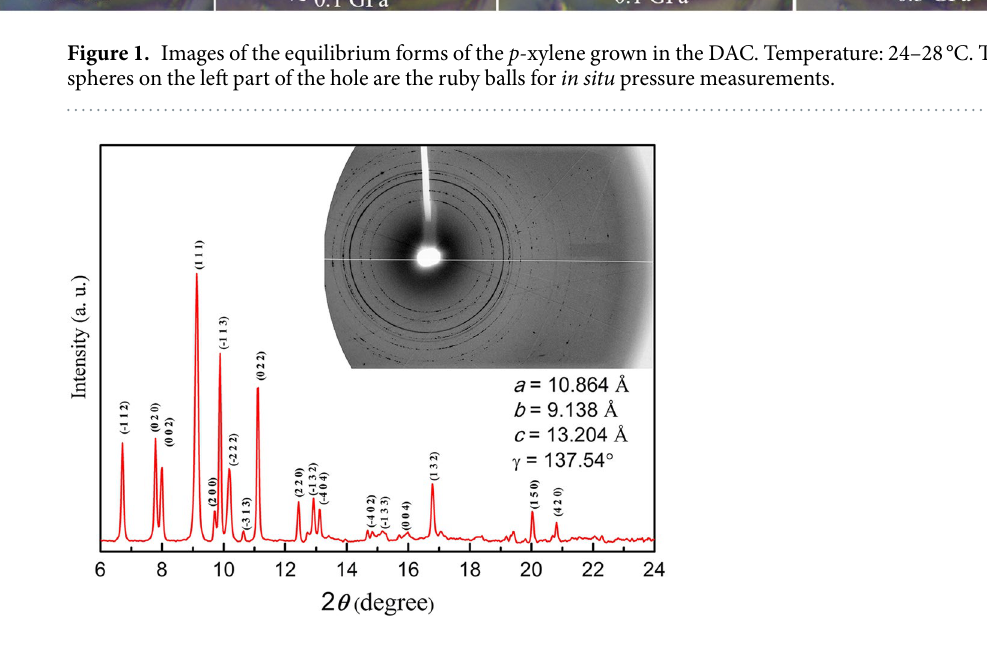
Figure 2. Powder X-ray diffraction pattern of p -xylene at 0.84 GPa. The calculated diffraction lines for this crystal structure are assigned. The inset shows the 2D diffraction